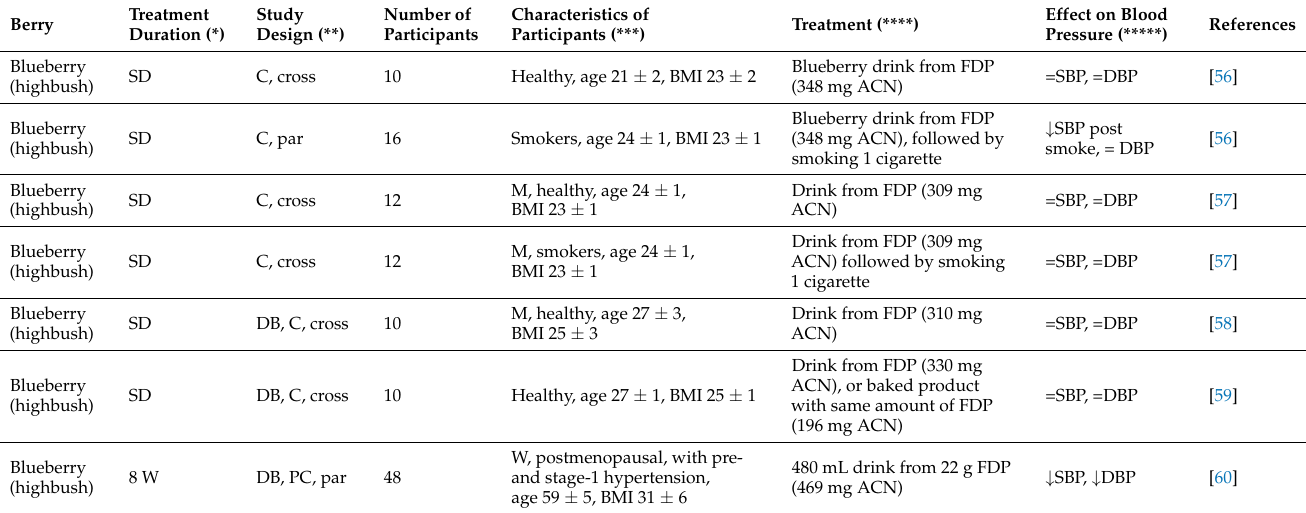
Table 1. Summary of findings related to blood pressure in berry intervention